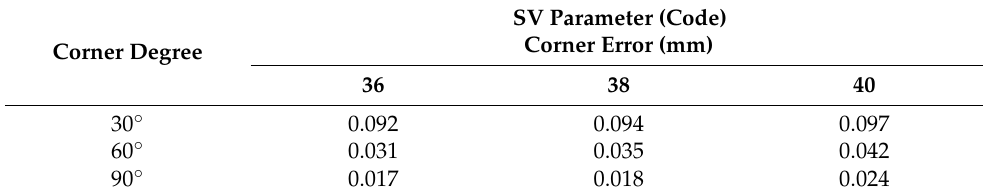
Table 9. Servo voltage (SV) vs. corner error.